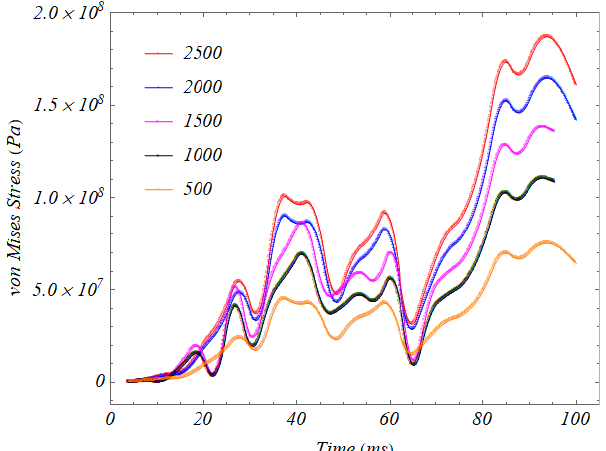
Fig. 21. von Mises stress against time for various drop distances with four cellphone casing laminates.